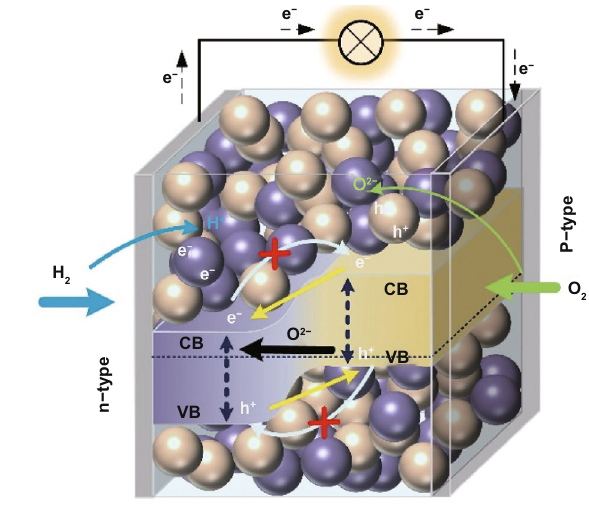
Fig. 9 Band structure and alignment for a bulk p – n heterojunction SIFC